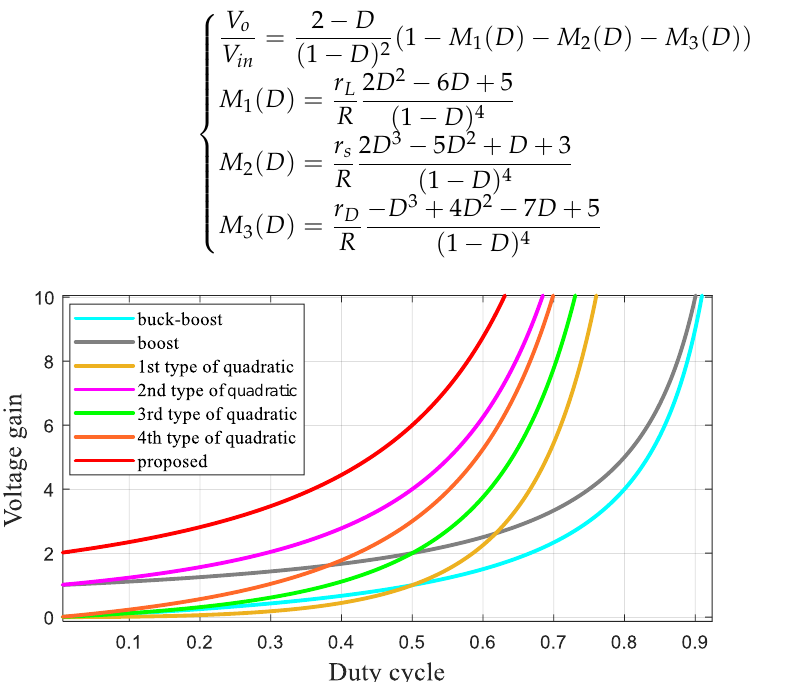
Figure 3. The comparison of the ideal voltage gain of the proposed converter with the conventional converters and various types of the quadratic